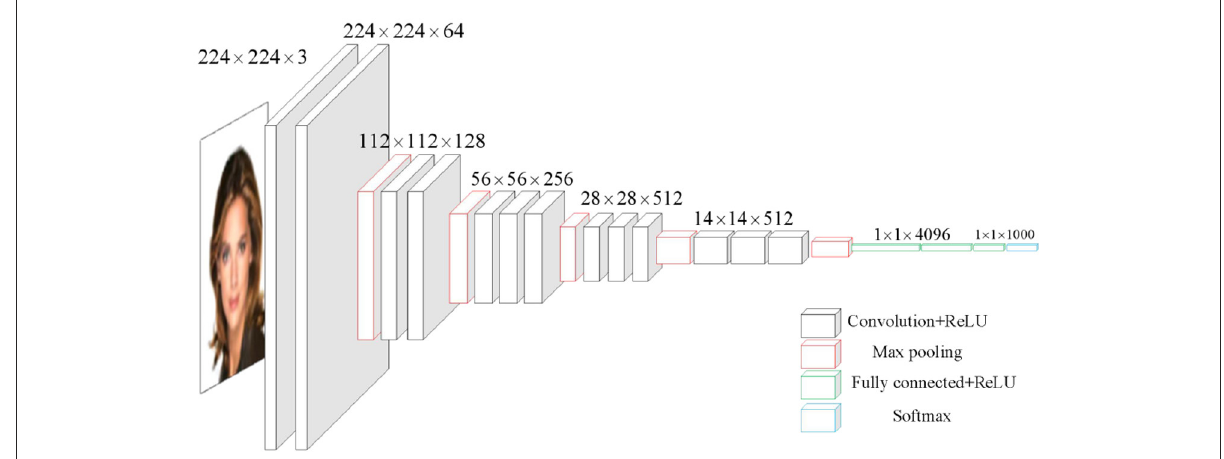
FIGURE2 The structure of a VGG16 module. The face images are adapted from the celeba-HQ dataset, which comes from Karras et al. (2017).